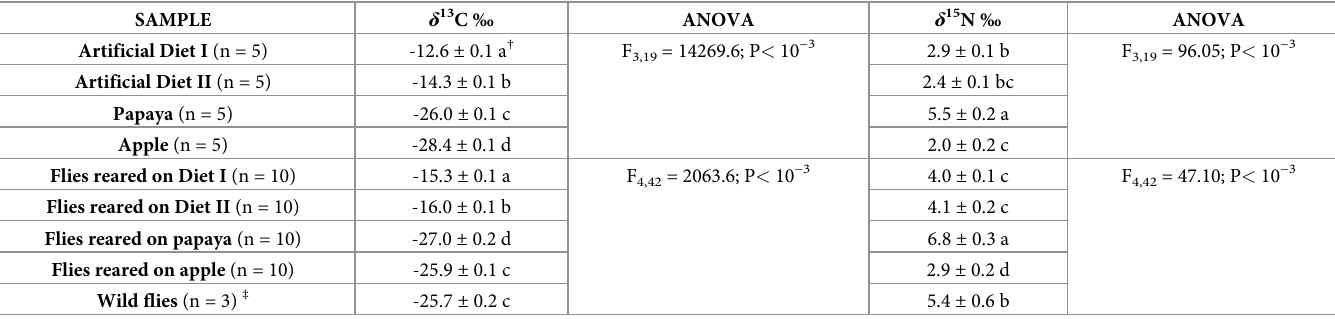
Table 4. Isotopic composition of larval diets, fruits, laboratory and wild Anastrepha fraterculus flies.